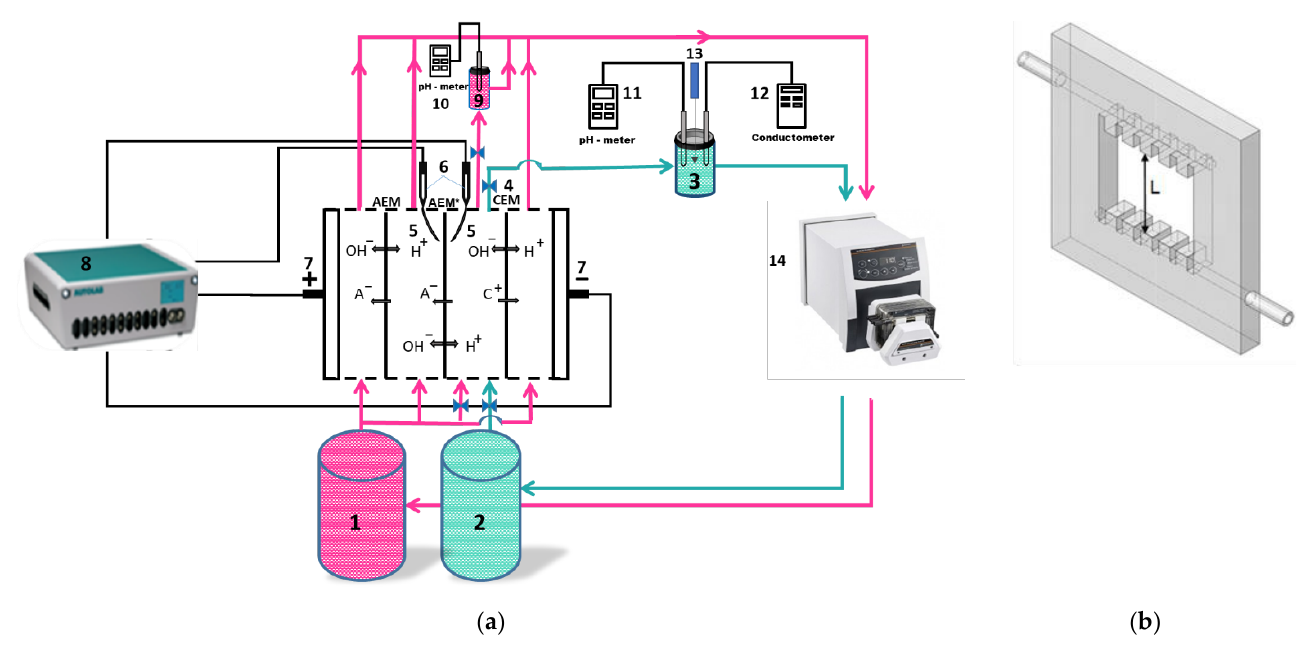
Figure 1. Scheme of the experimental setup ( a ) and a plexiglass frame with special comb guides ( b ) to ensure the laminar hydrodynamic solution flow. Explanations are in the text. Table 2. Select parameters of the laboratory ED cell and experimental conditions. Active membrane surface area, S , cm 2 4.00 ± 0.01 Intermembrane distance, h , cm Compartment length, L ,